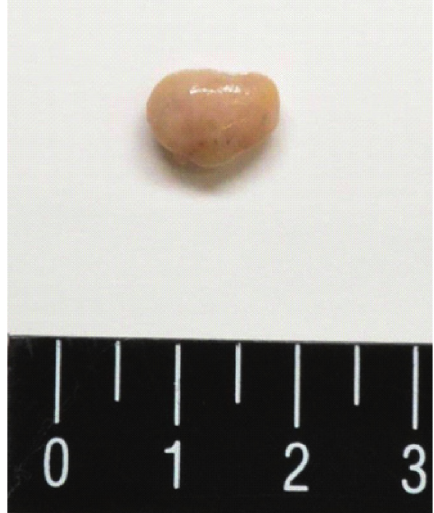
Figure 1: Gross specimen image. The specimen was sized at approximately 10mm in diameter.